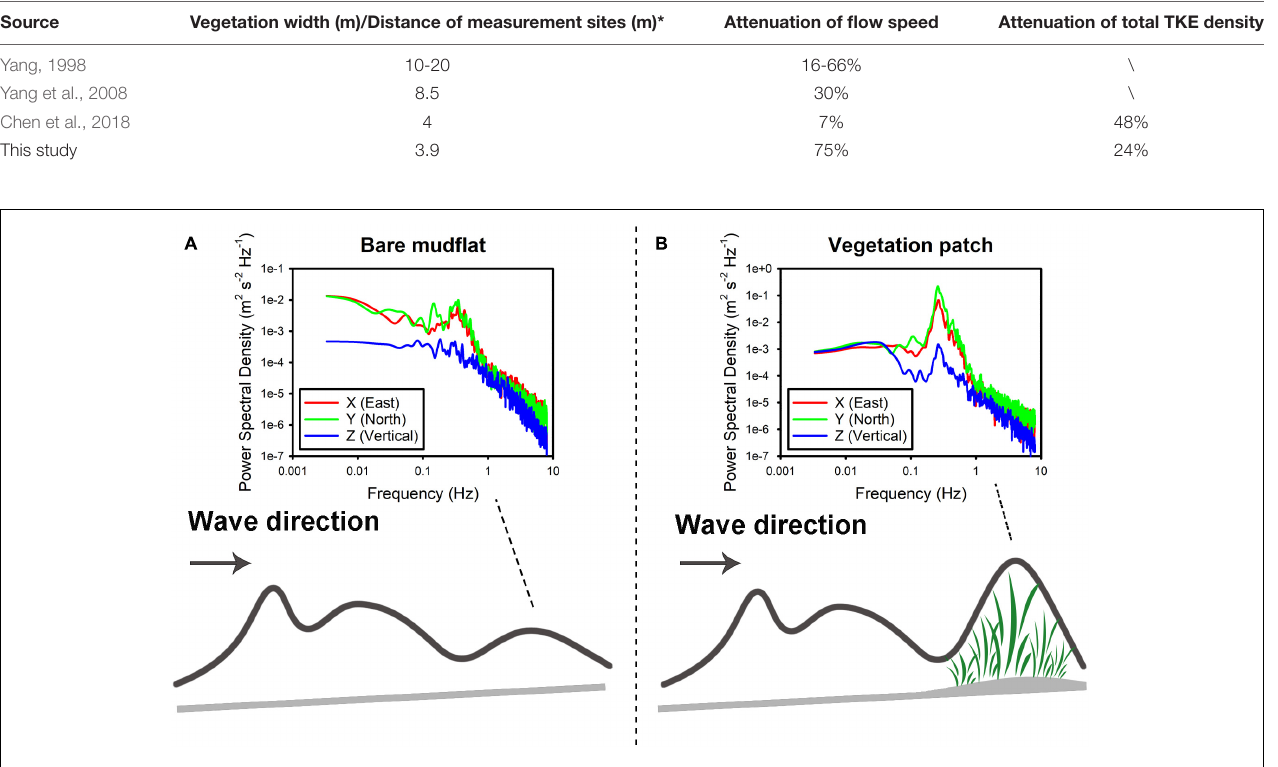
FIGURE 7 | Wave strengthening occurs under the combined action of elevation and vegetation: (A) wave motion in the bare mudflat; (B) wave enhancement when the vegetation patch appears.